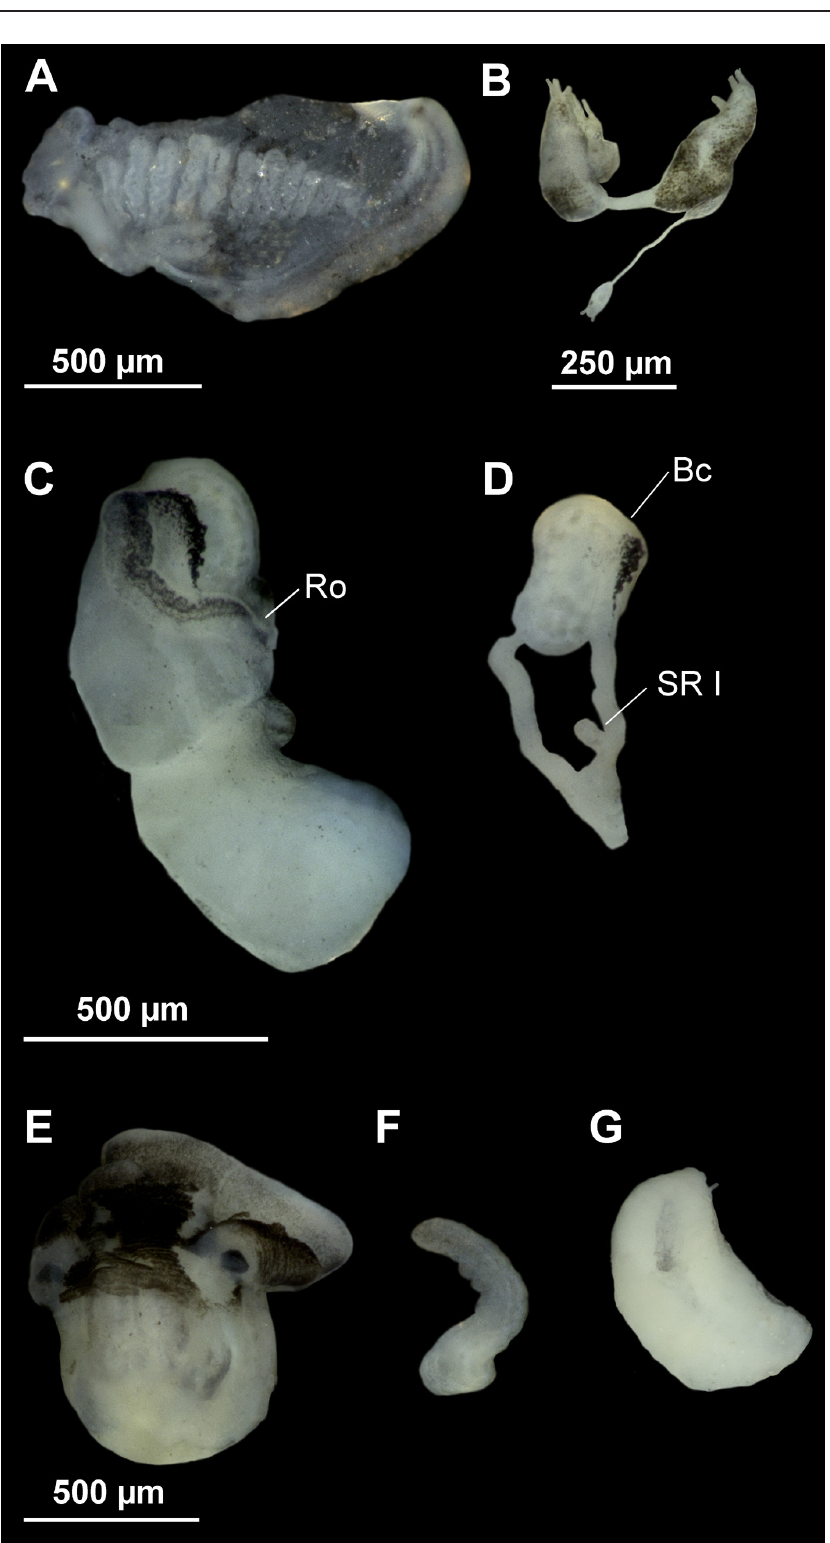
Fig. 7. Anatomy of Persipyrgula saboori (Glöer & Pešić, 2009) gen. et comb. nov. from Zou